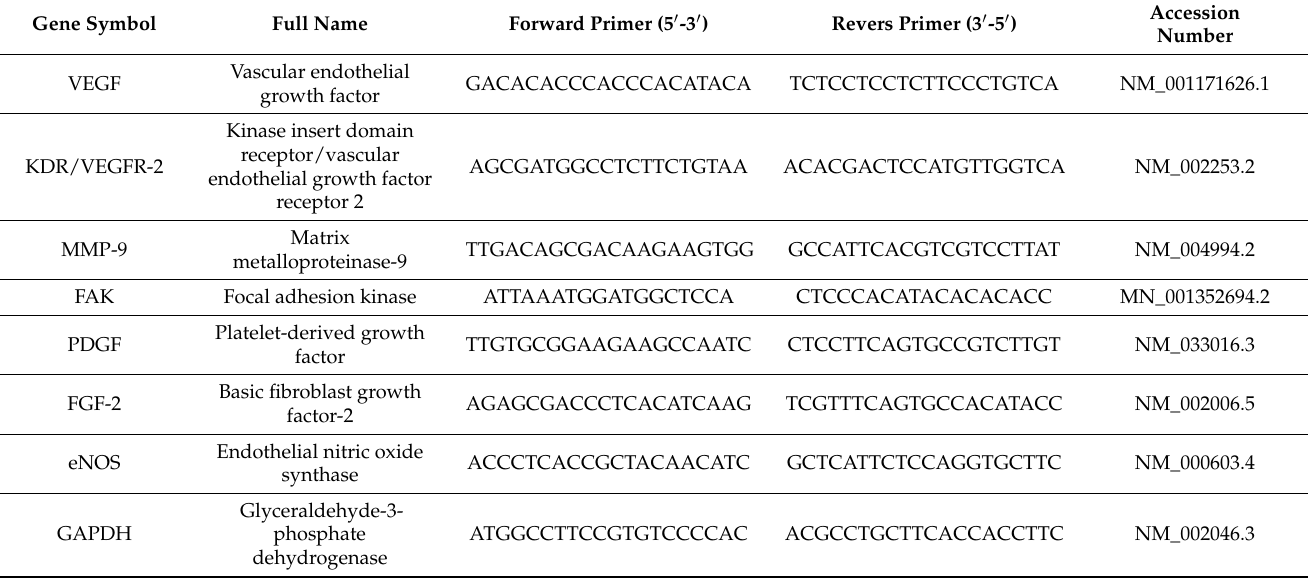
Table 2. Primer sequences used for qPCR